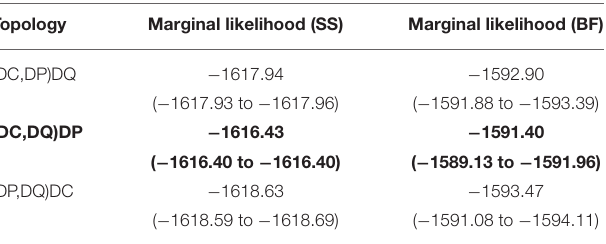
TABLE 3 | Marginal likelihood calculations for the three tree topologies using subset of COI sequences (see text for details) by placing a hard constrain to force different sister relationships within the Deania